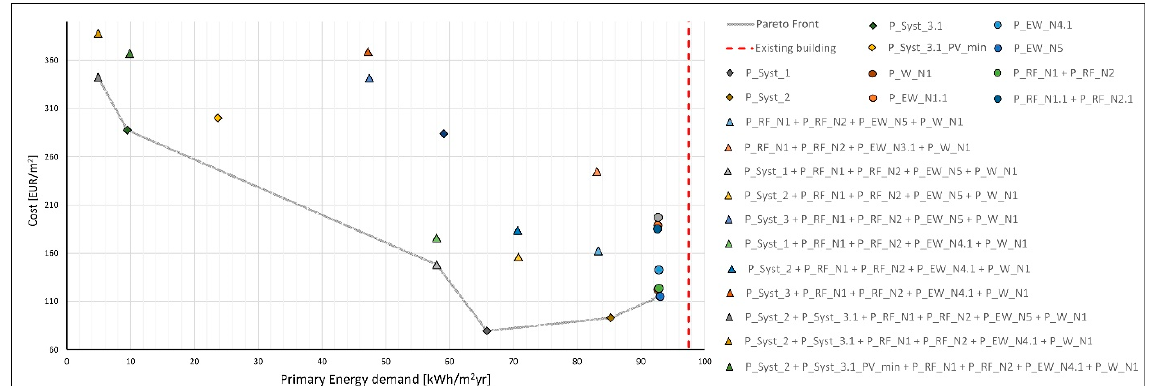
Figure 13. Cost-optimality method results for the financial scenario for both single redevelopment measures and their combinations and discount factor equal to 4% for Poliziano school. The red line in the graph shows the primary energy consumption for the existing building.